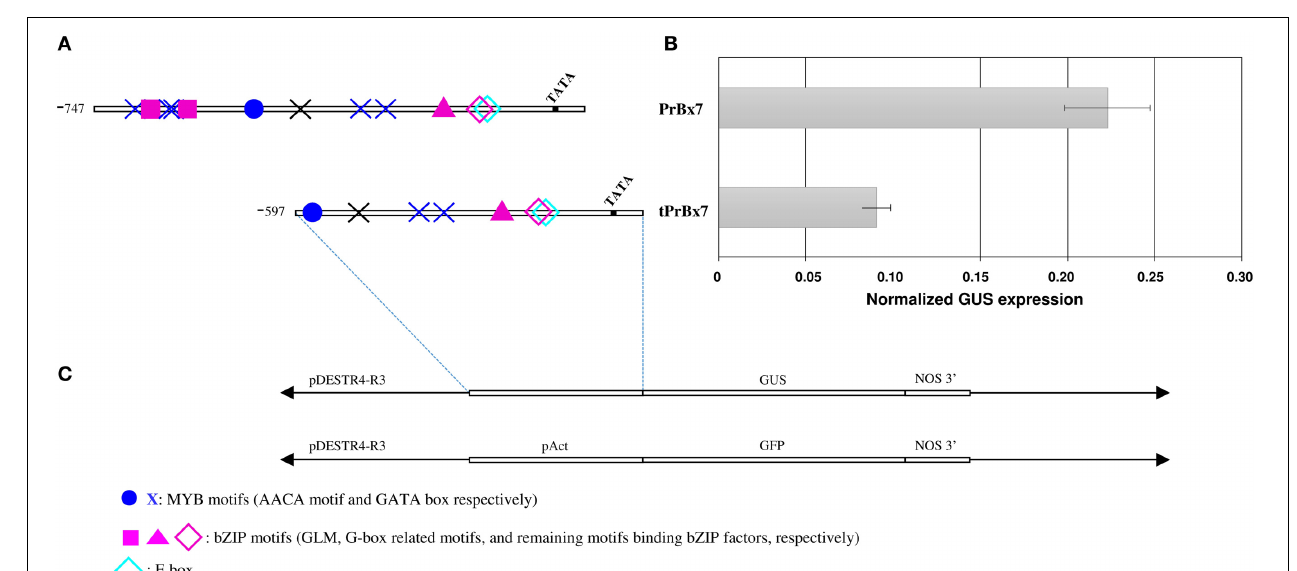
FIGURE 6 | Activity of Glu-B1-1 gene promoter from cv. Renan (Bx7) in immature wheat endosperms using a transient expression assay. (A) Schematic representation of the constructs used. The TATA box and nucleotide positions relative to the start codon and corresponding to deleted region are indicated. Putative cis -regulatory elements, E-box ( − 259), G-box ( − 277), GATA box ( − 658, − 638, −